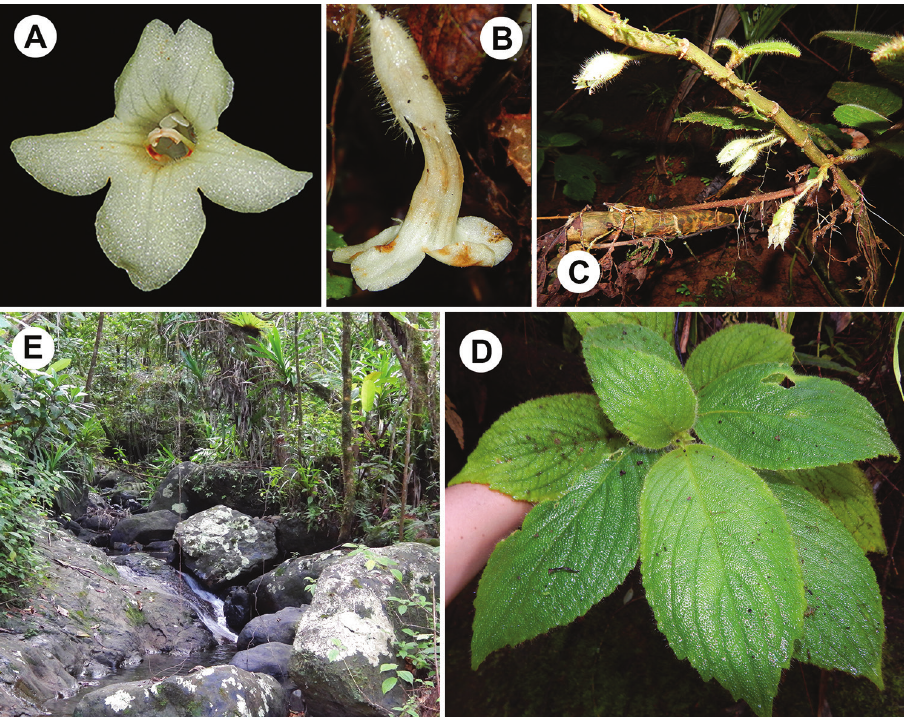
Figure 11. Cyrtandra waisaliensis M.A.Johnson. A Corolla, anterior view B Flower, lateral view C Cau- liflorous cyme inflorescence D Shrub habit E Rainforest understory habitat. All photos from the type collection, taken in the field by M.